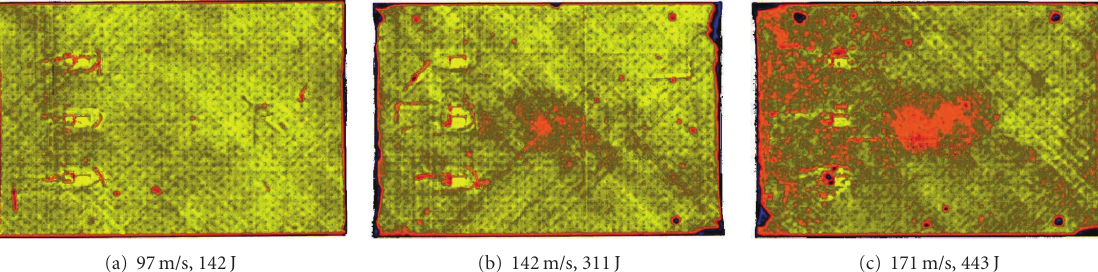
Figure 4: Increasing damage with increasing impact velocity visualised by ultrasonic C-scans of specimens with tensile preload (no delaminations but only matrix cracking).